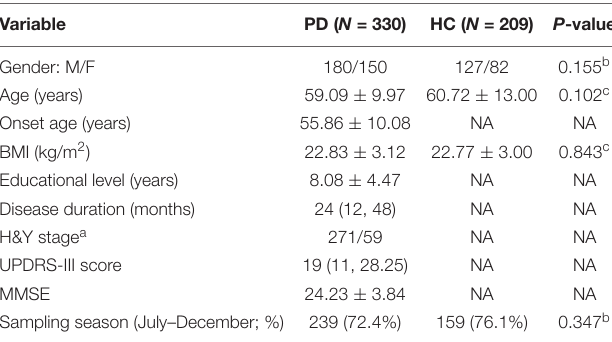
TABLE 1 | The demographic and clinical data of Parkinson’s disease patients and health controls (HC). Variable